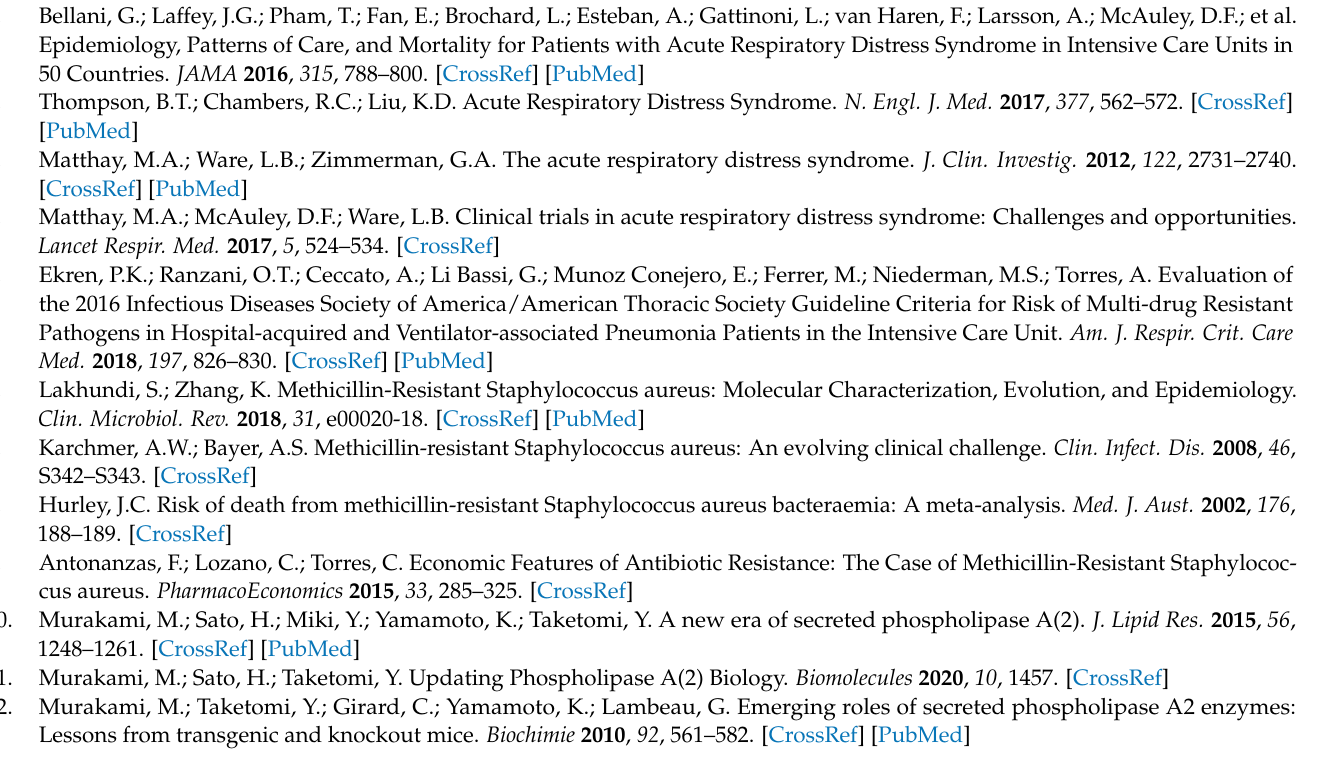
Figure S3: Unedited